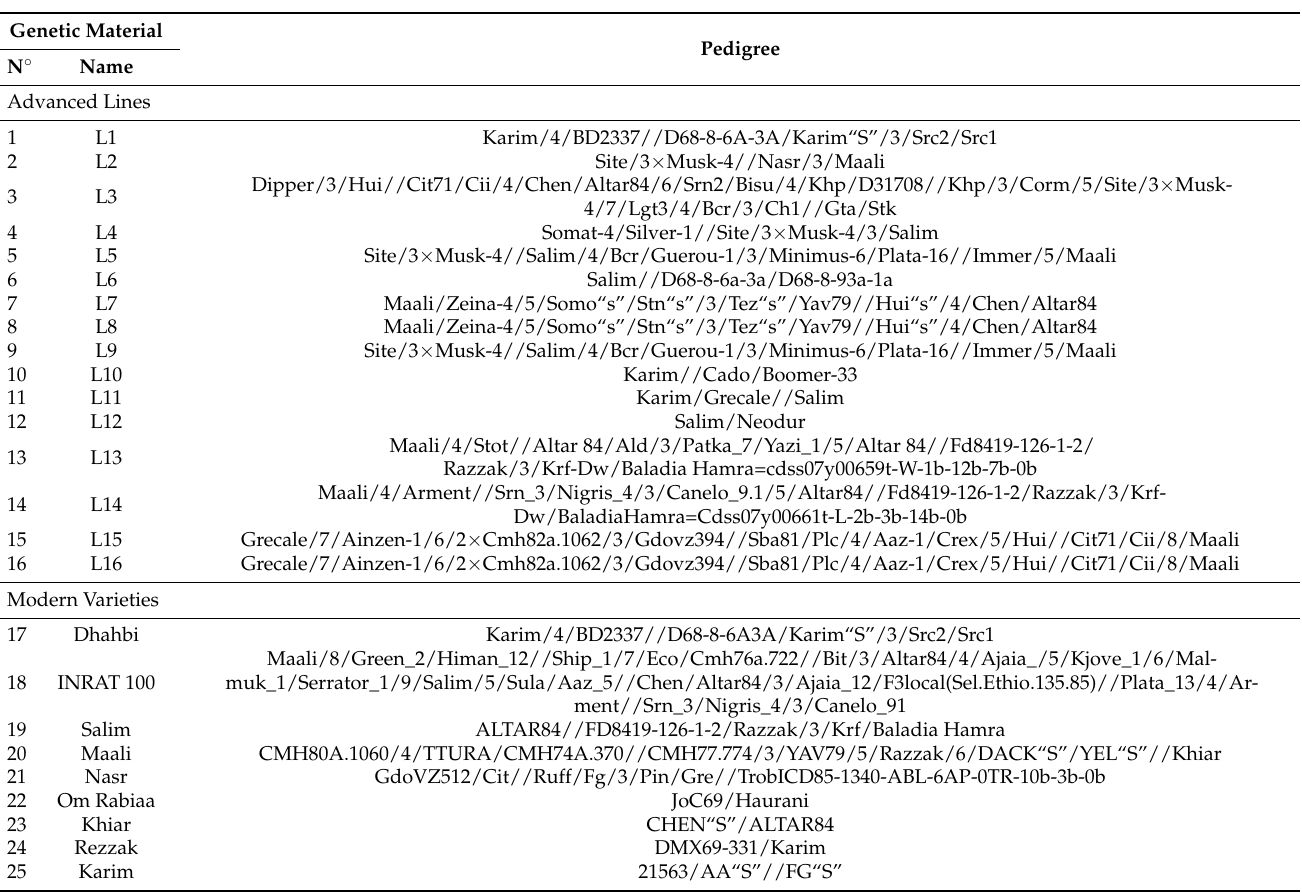
Table 5. List and pedigree of durum wheat advanced lines and modern varieties used in the study.